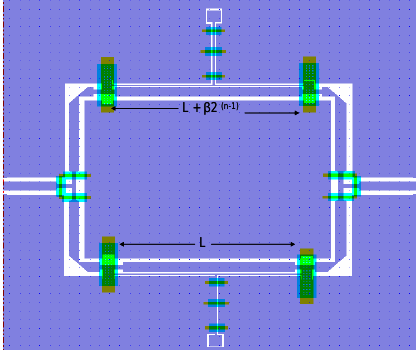
Figure 3: n th bit layout of the phase shifter